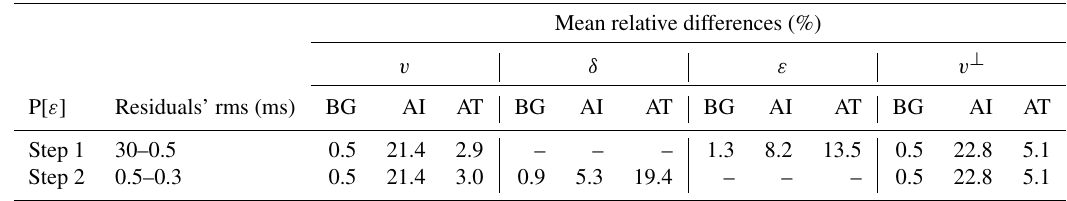
Table 5. Same as Table 4 but for the two-step sequential inversion of P[ ε ] (Fig. 7). Recoveries in terms of model fit are virtually identical to those for the simultaneous inversion of this parameterization, with ε recovery being just slightly better. Final data fit is also better than the one achieved by simultaneous inversion of P[ ε